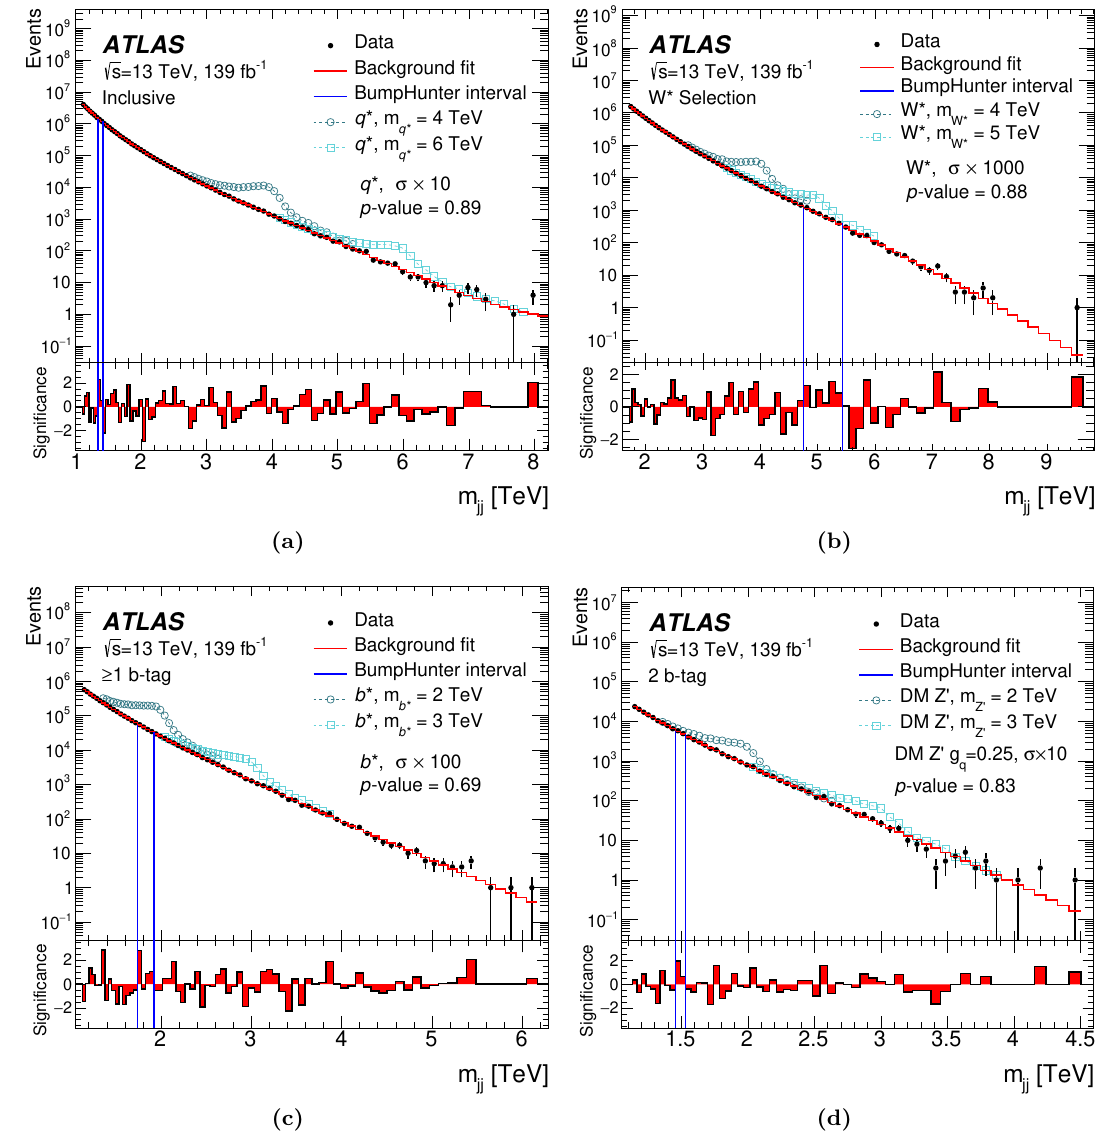
Figure 3 . Dijet invariant mass distributions from multiple categories: (a) inclusive dijet with j y (cid:3) j < 0 : 6, (b) inclusive dijet with j y (cid:3) j < 1 : 2, (c) dijet with at least one b -tagged jet and (d) dijet with both jets b -tagged. The vertical lines indicate the most discrepant interval identi(cid:12)ed by the BumpHunter test, for which the p -value is stated in the